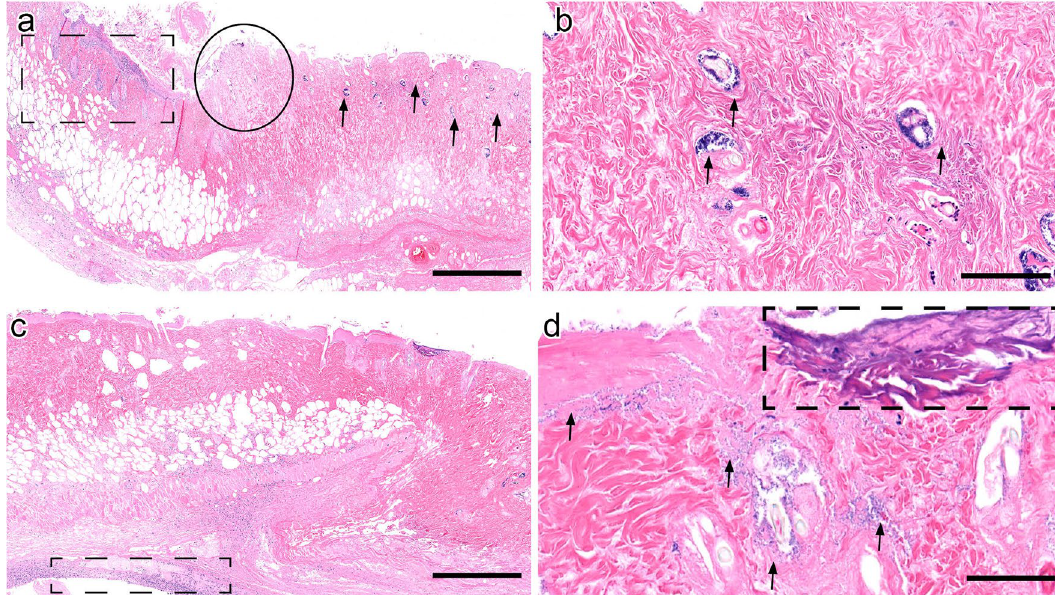
Figure 2. Histopathology of murine pressure ulcers infected with MRSA and treated with oral clindamycin or topical auranofin alone for four days. ( A ) Clindamycin-treated animals demonstrated the most pronounced wound healing with wound contrition (circle) and very few bacterial colonies present in the dermis (arrows). Inflammation was minimal and peripheral to the wound (dashed black box). Wounds demonstrated further resolution of inflammation and angiogenesis in the deep subcutis (solid black box). Scale bar represents 1 mm. ( B ) On closer view, bacteria are present in clusters within hair follicles (arrows) (image acquired at 2 × magnification). Scale bar represents 100 μm. ( C ) Auranofin-treated ulcers revealed a marked decrease in bacterial burden compared to systemic clindamycin treatment with mild inflammation deep in the subcutis (dashed box) (image acquired at 2 × magnification). Scale bar represents 1 mm. ( D ) Some foci of superficial mineralization (dashed box) were seen in auranofin-treated animals (image acquired at 20 × magnification). Scale bar represents 100